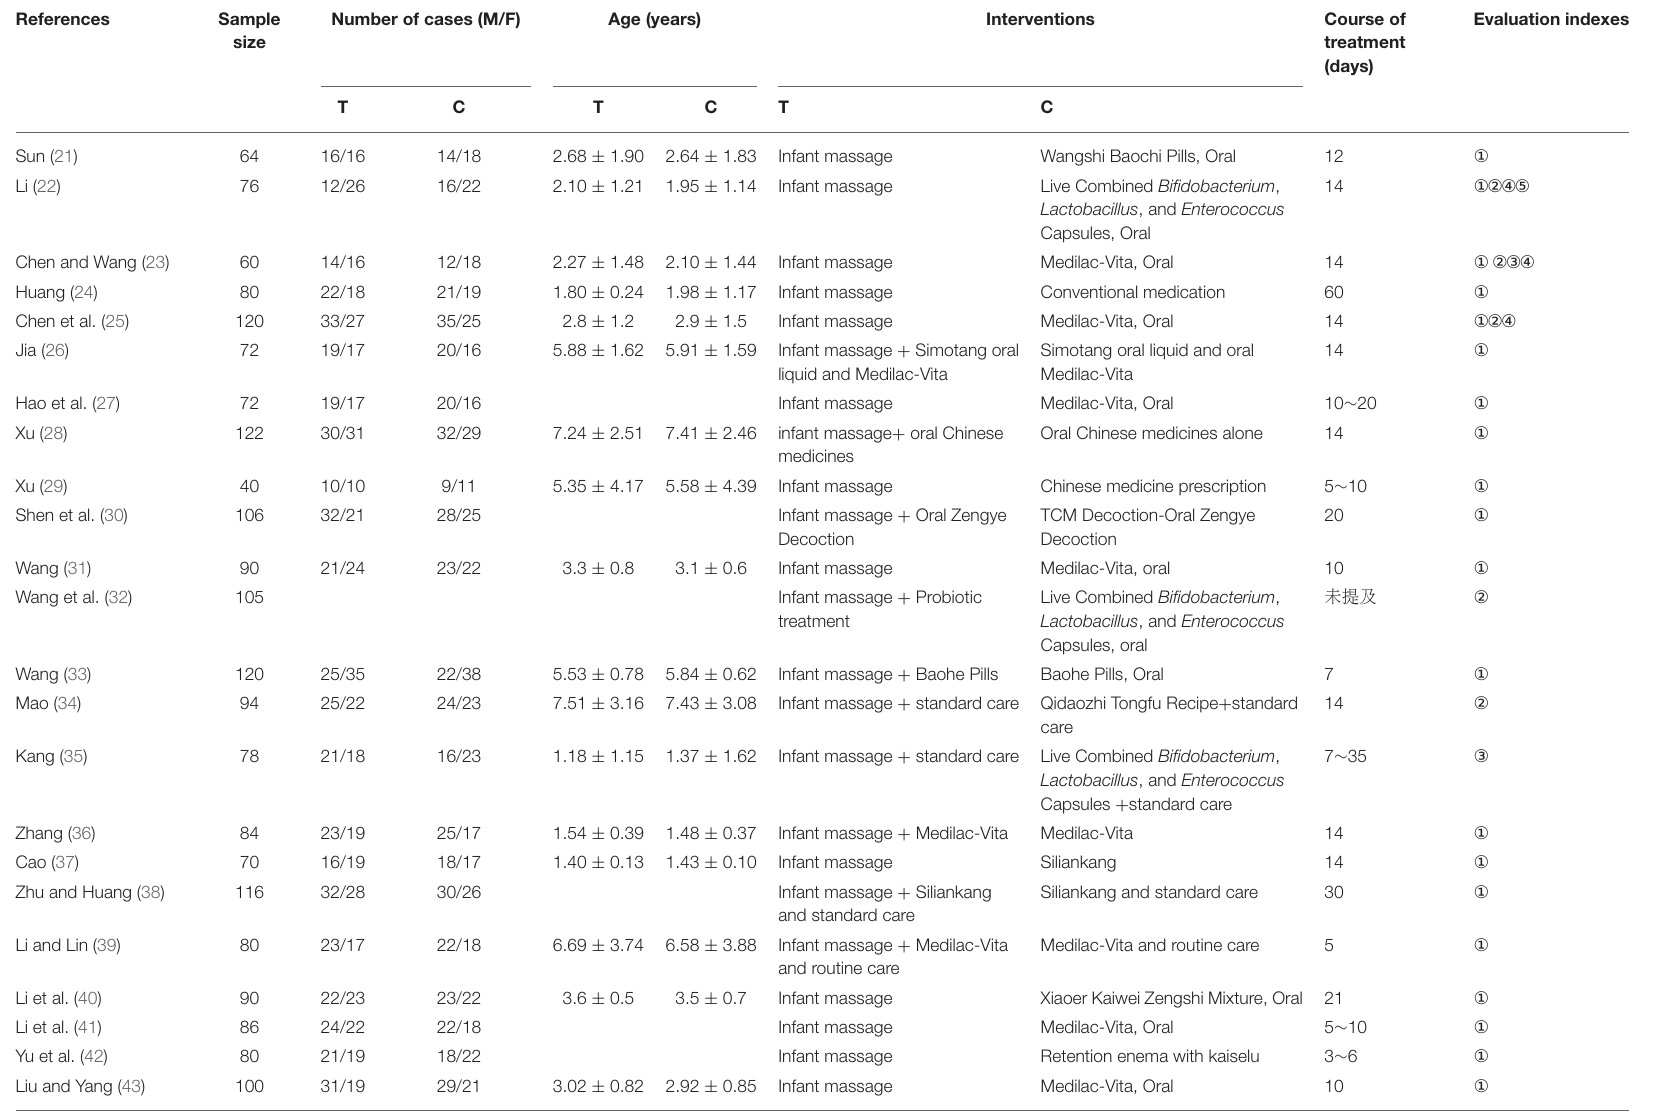
TABLE 1 | Basic characteristics of the included literature.